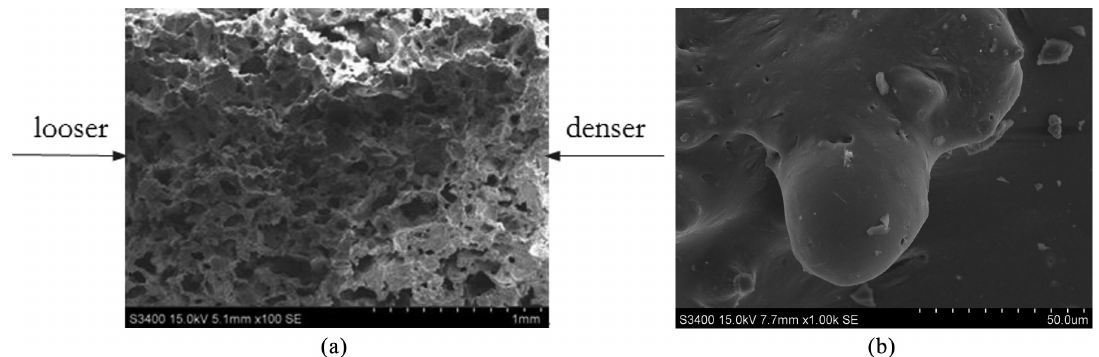
Figure 3. SEM images of the cross-section of the HCP scaffolds (a) and SS loaded collagen microparticles embedded in the scaffolds (b).